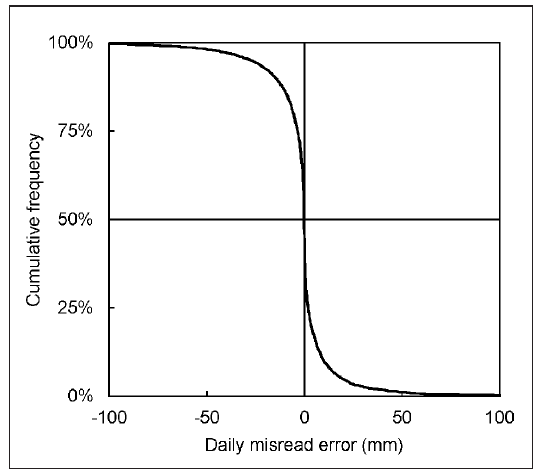
Figure 2: Cumulative distribution of daily misread errors ( n = 3,440). Dry days on which both the automatic and manual gauges registered zero rainfall ( n = 1,592) have been